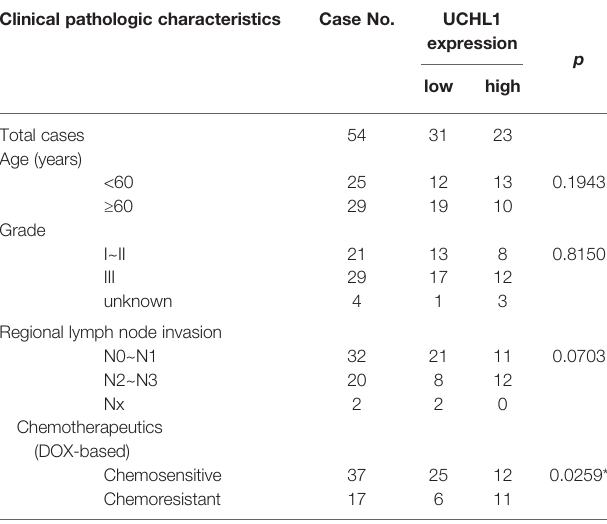
TABLE 1 | The association between UCHL1 expression and clinical pathologic characteristics in 54 patients with BC. Clinical pathologic characteristics